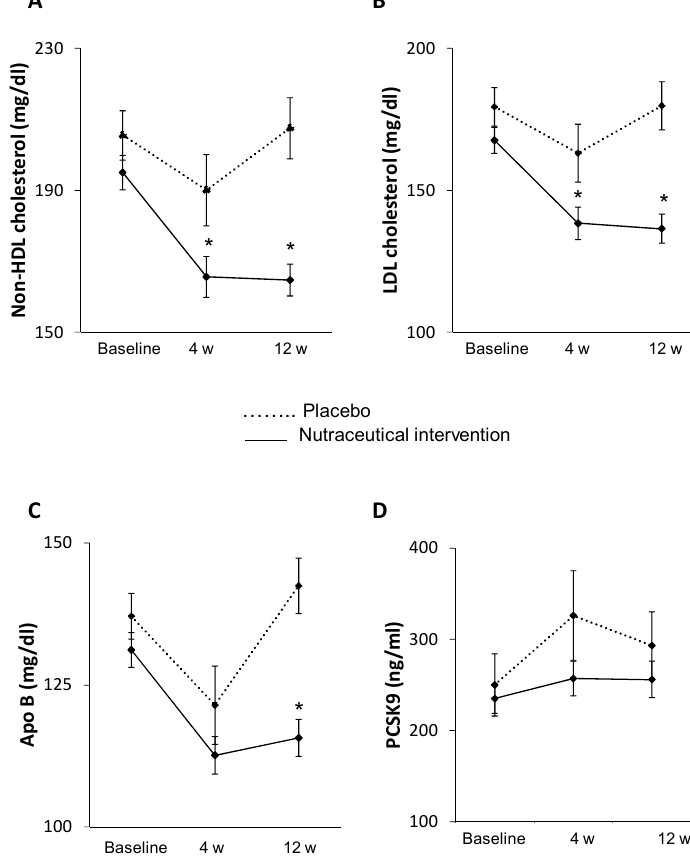
Figure 2. Lipid levels at baseline, 4 and 12 weeks of treatment in both study arms. Effect of treatment on non-HDL-cholesterol ( A ), LDL-cholesterol ( B ), Apo B ( C ) and PCSK9 ( D ) levels at 4 and 12 weeks. Mean values ± standard error (SE) are presented. * p < 0.05 vs. placebo (GLM: general linear model) (HDL: high-density lipoprotein; LDL: low-density lipoprotein, Apo: apolipoprotein, PCSK9: Proprotein convertase subtilisin/kexin type 9).